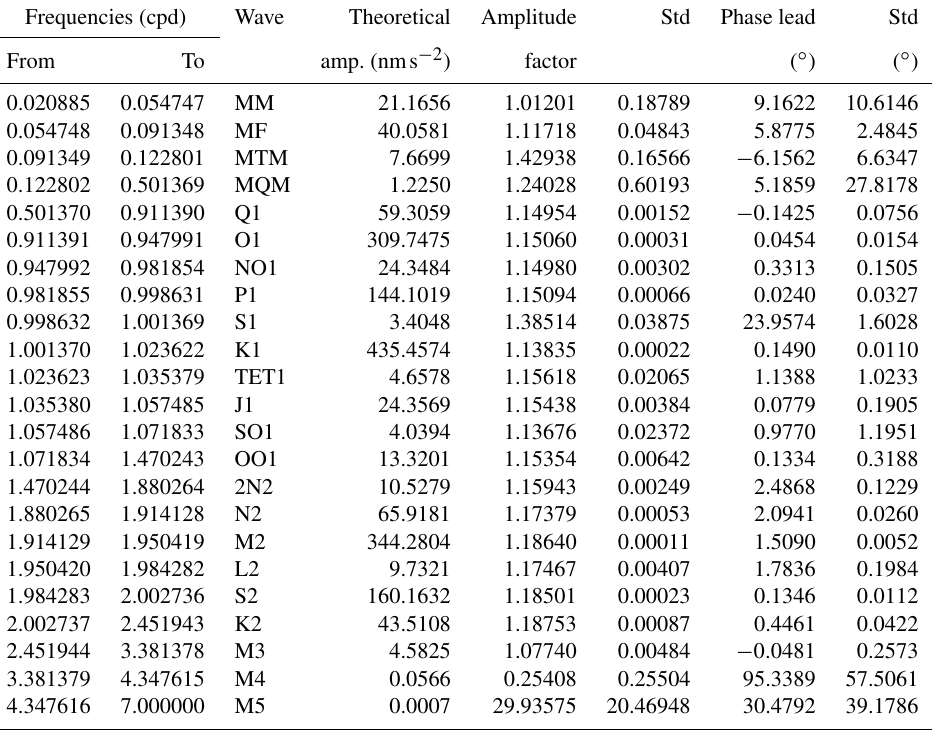
Table 2. Estimated amplitude factors and phase leads from a least squares adjustment of 23 tidal waves based on 2 years of gravity observa- tions with OSG 052 at